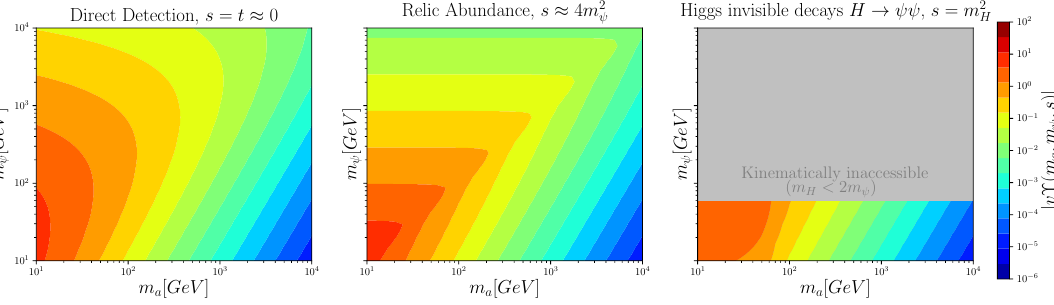
Figure 19. Dimensionless loop function v Υ( m a , m ψ , s ) (where v is the SM Higgs vacuum expec- tation value) for the three scales of interest to the